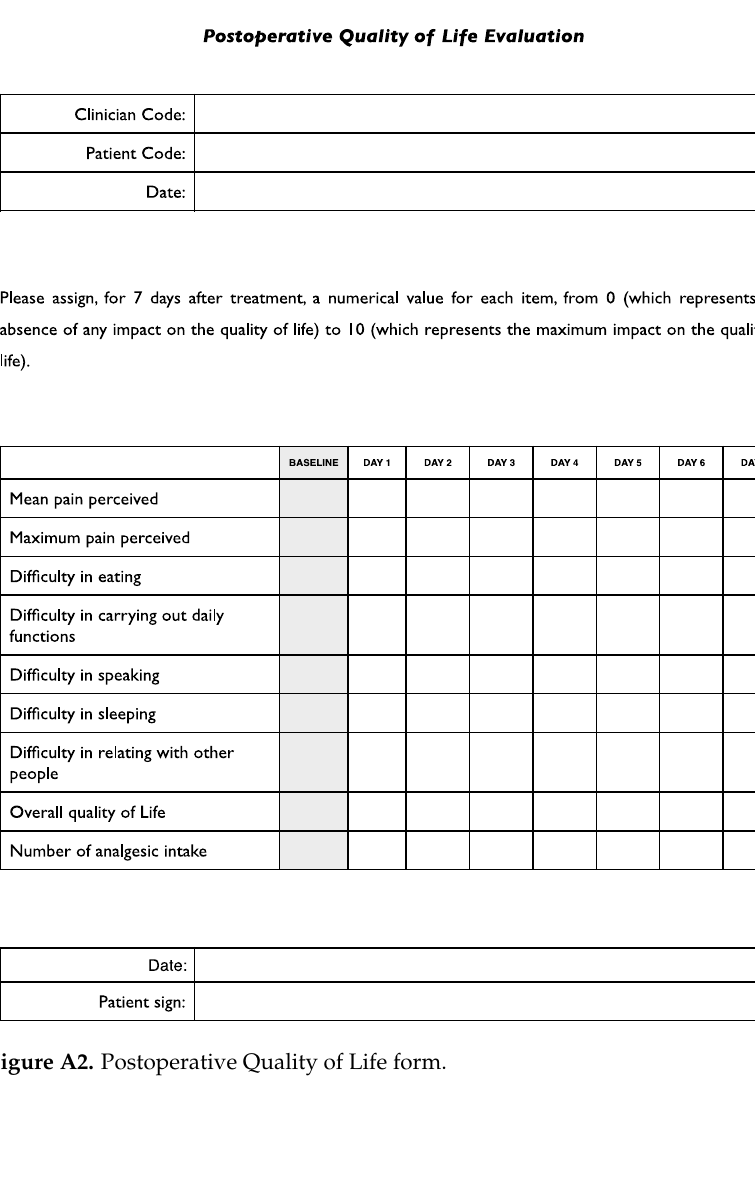
Figure A2. Postoperative Quality of Life form.